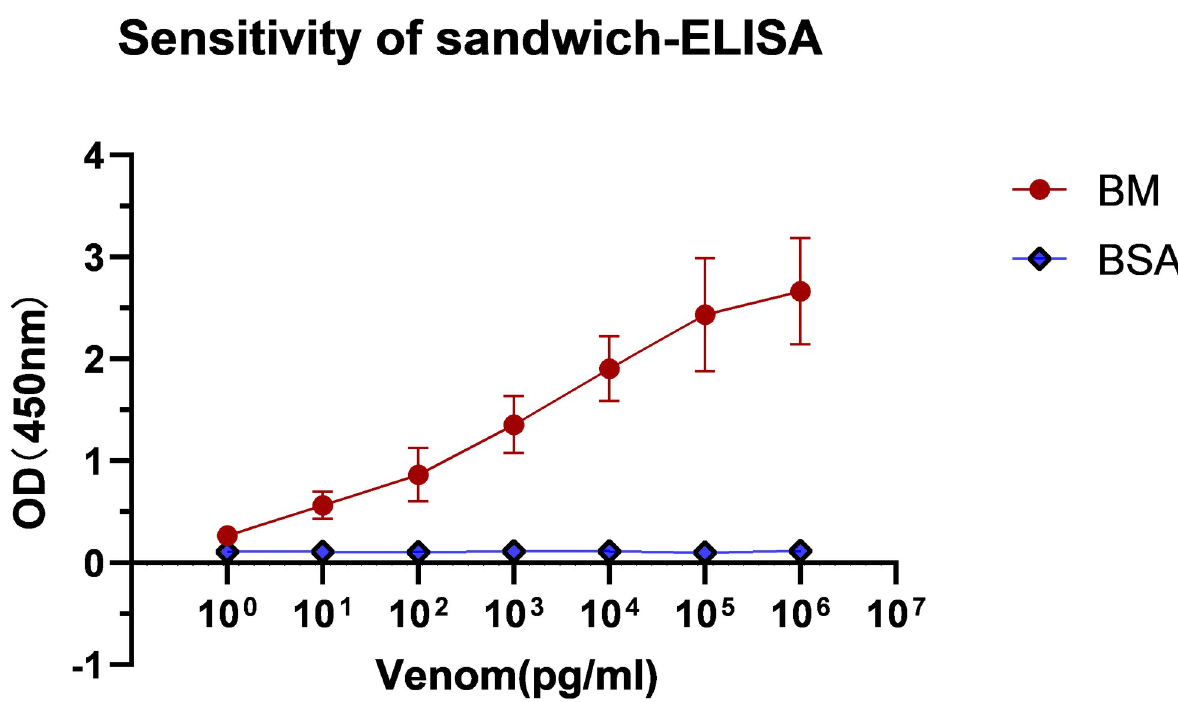
Fig 7. Sensitivity of sandwich ELISA at spiked venom samples. The rabbit APAb (2 μ g/ml) as the capture antibody coated on a micro-ELISA plate. Known concentrations of BM venom (0.001–1000 ng/ml) were applied and then tested with SSAb (1 mg/ml) 1:10,000 diluted in PBST. The test was done in triplicate, and BSA was used as a blank. Quantitative data are presented herein as mean ± SD.